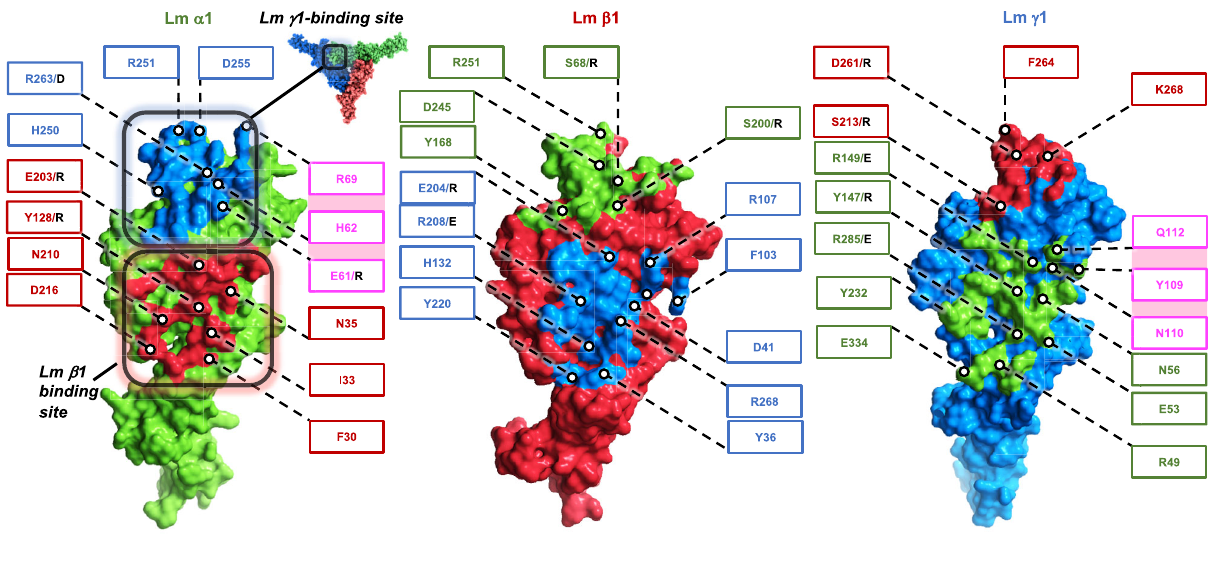
Fig. 2 | Inter-subunit interfaces stabilizing the Lm polymer node. Lm α 1 and inter-subunit interfacesformed by α 1 with β 1 and γ 1 are showningreen. Lm β 1 and γ 1 subunits and their correspondent inter-subunit interfaces are displayed in red and blue, respectively. Previously described mutations resulting in disruption of